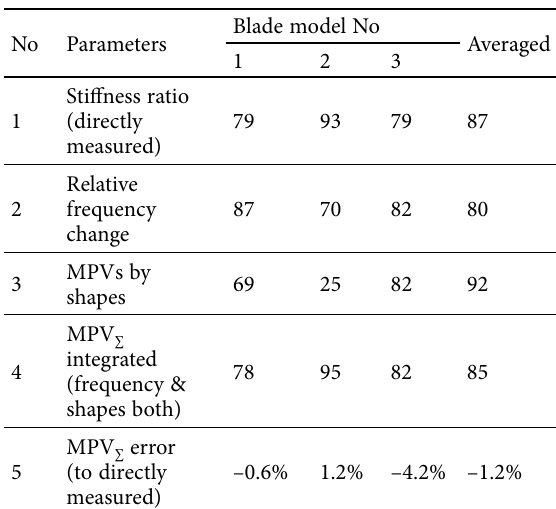
Table 1. Modal assessments (MA) of blade model